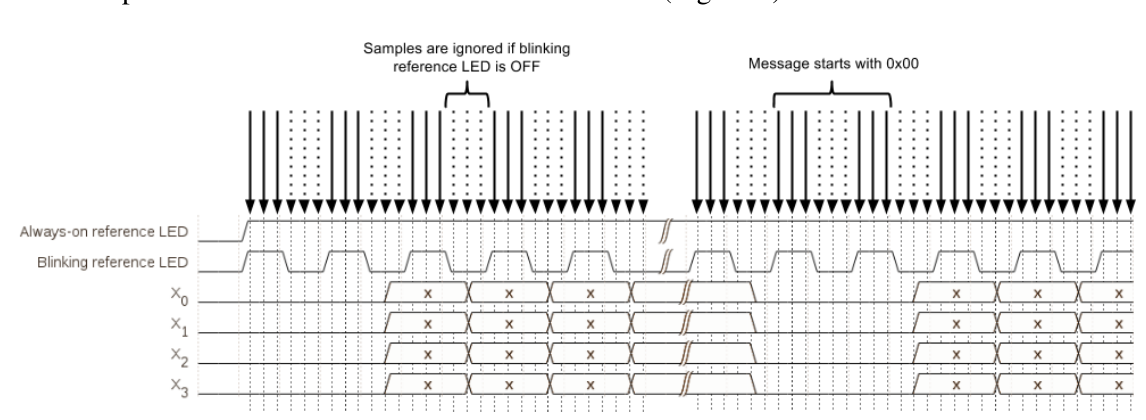
Figure 5. Sampling sequence for dynamic augmented reality (AR) marker